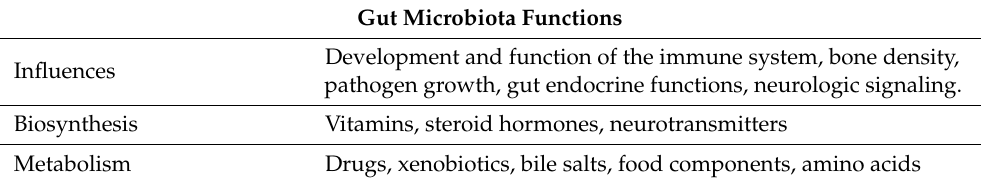
Table 2. Gut microbiota